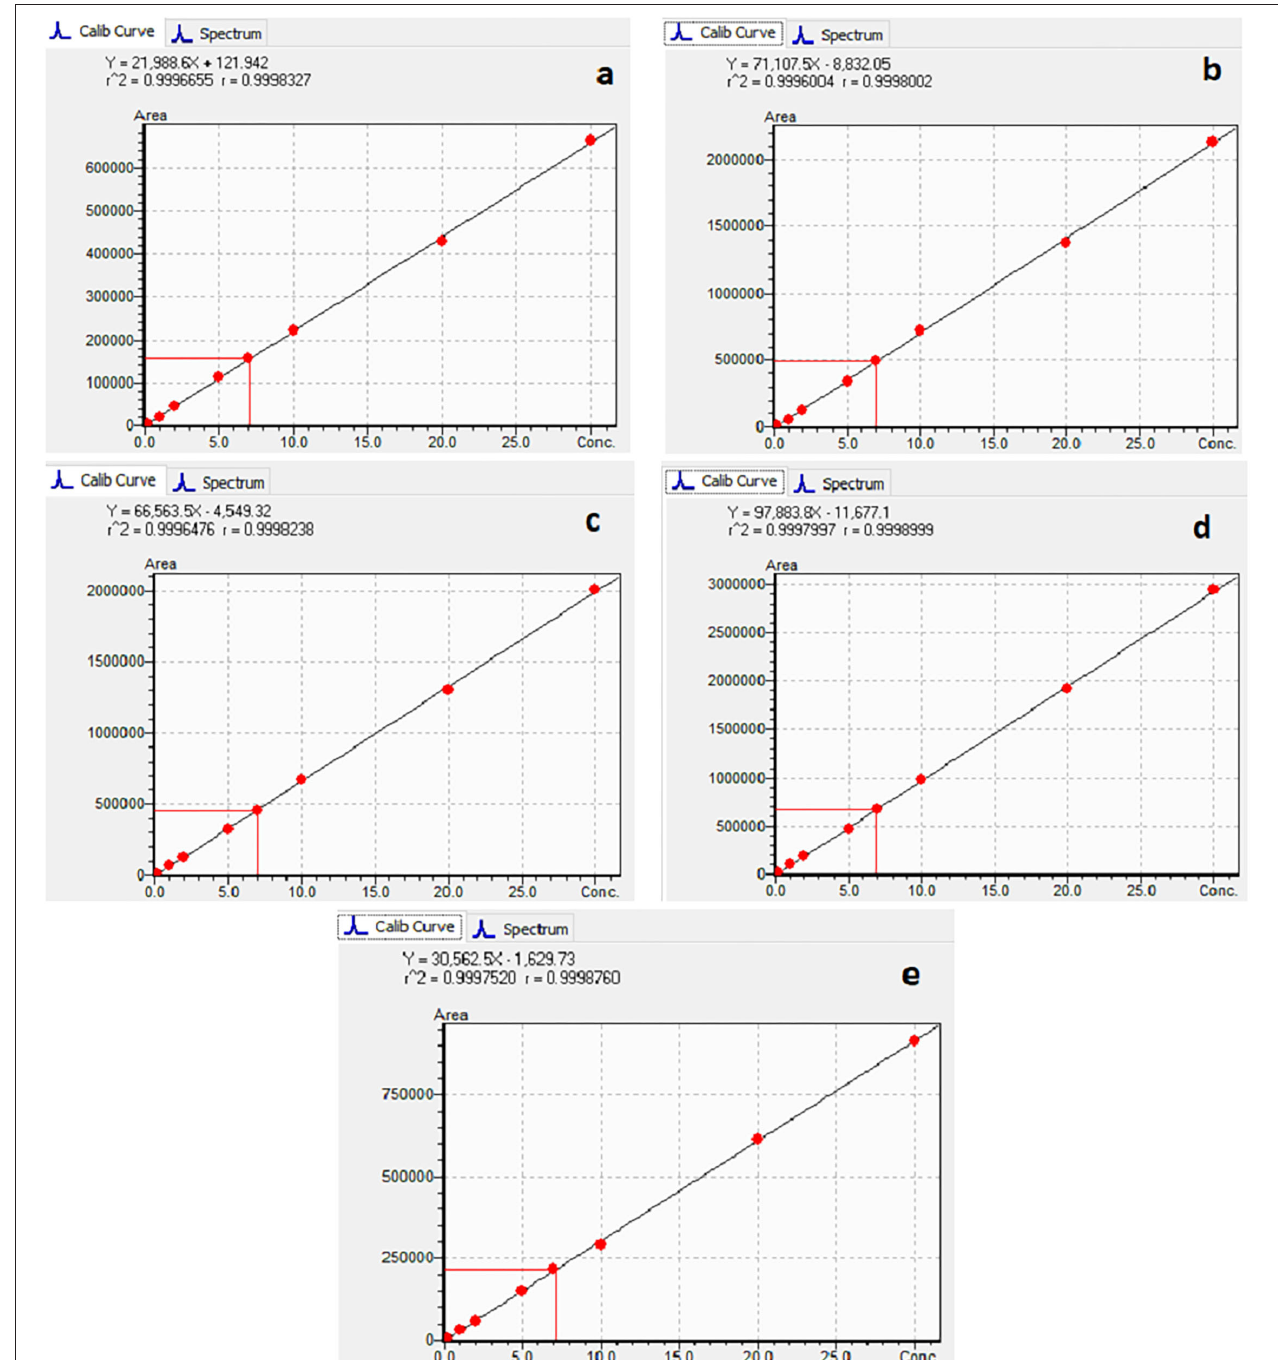
small or large quantity when compared to the mean for the data set. The matrix effect was evaluated using the post-extraction spike method, by adding standard solutions of mycotoxins into the matrix after extraction. Calibration curves of standard solutions of mycotoxins and spiked standard solutions